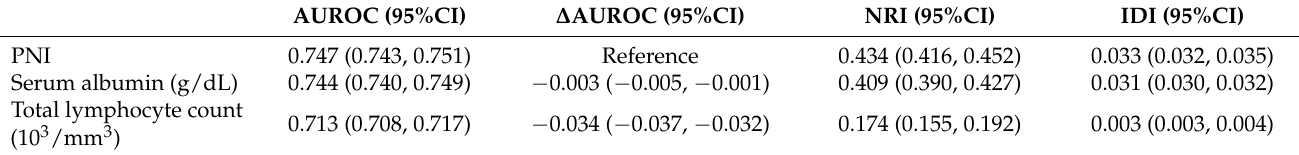
Table 2. Analyses of the area under the receiver operating characteristic curve, net reclassification improvement, and integrated discrimination improvement for one-year all-cause mortality by in- cluding the prognostic nutritional index, serum albumin level, or total lymphocyte count in the case-mix-adjusted logistic regression model.